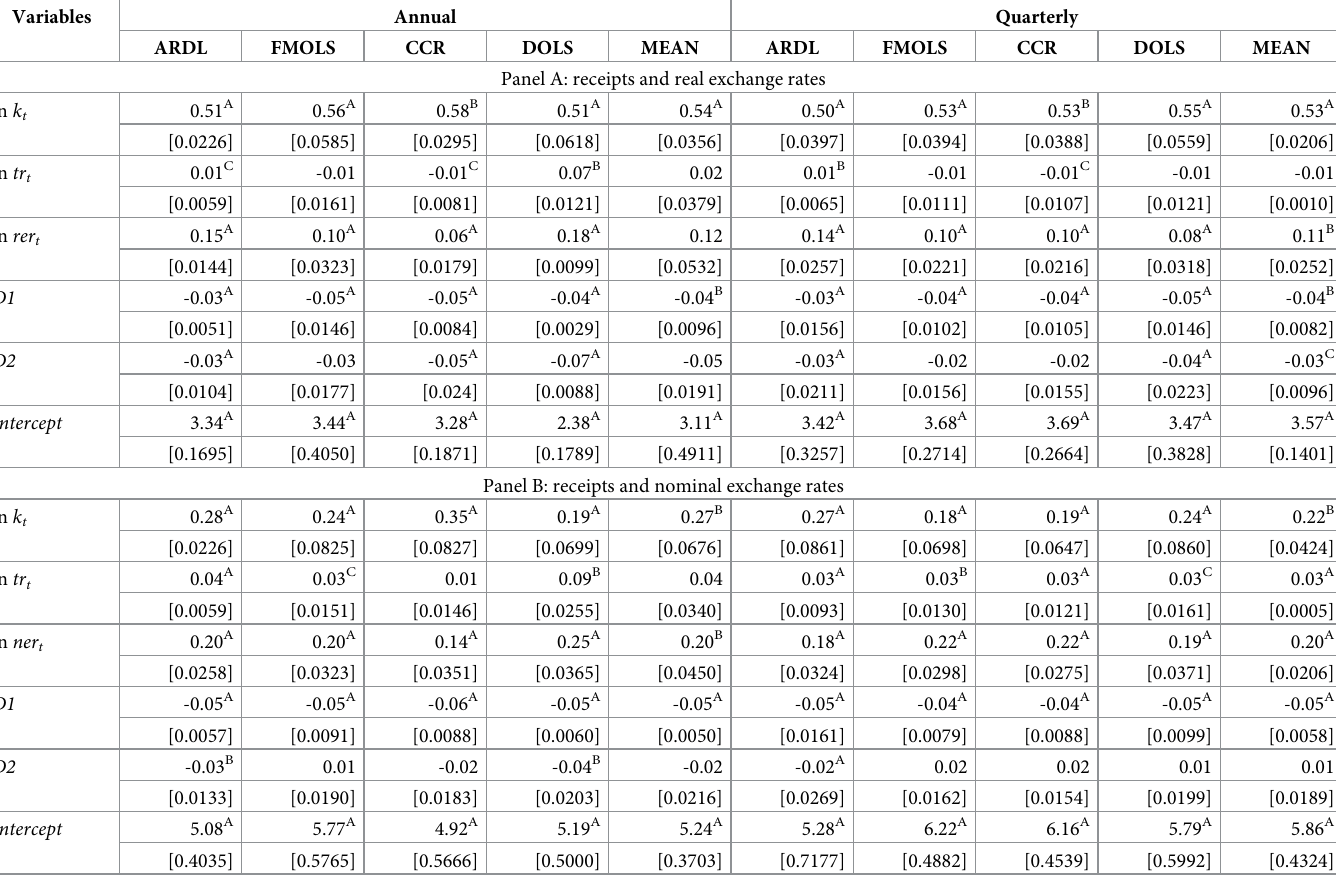
Table 8. Tourist receipts